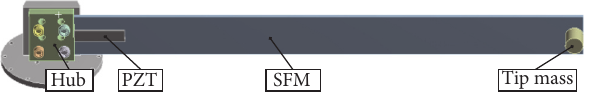
Figure 9: Three-dimensional model of the SFM with surface bonded actuators. Table 2: Structural parameters of SFM.